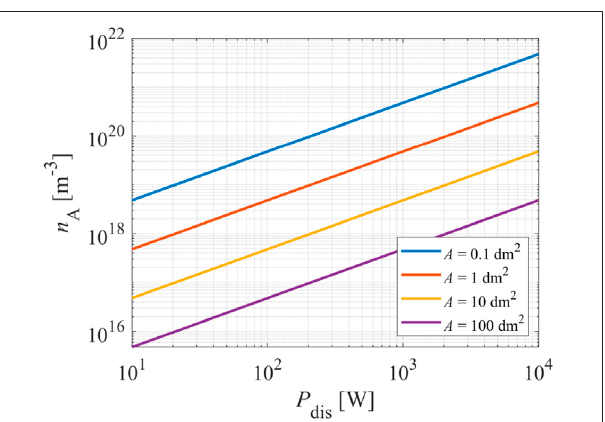
FIGURE 4 | The power dissipated on the non-inert surfaces of a plasma reactor versus the geometrical area of any plasma-facing materials. The calculations are credible for O-atoms of the density of 10 20 m − 3 .